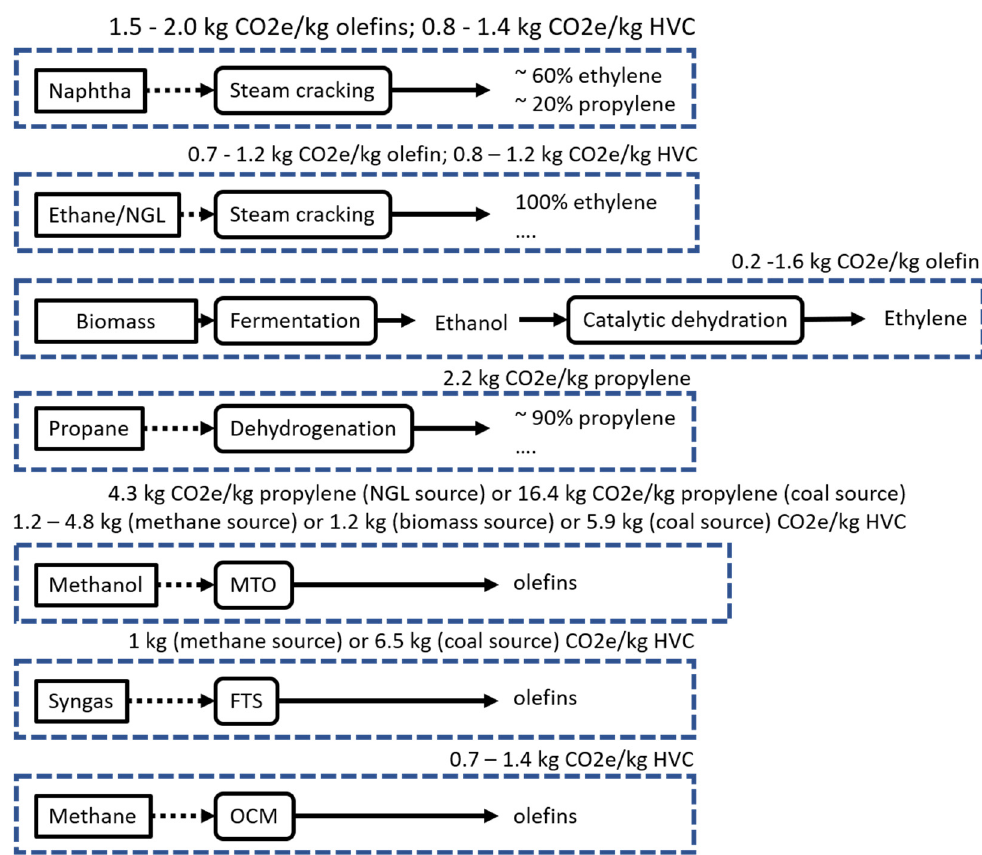
Figure 28. Schematic block diagram that describes the production of olefins through conventional and alternative processes. Data source: [2,38,42,46,47,49,53,74,98,514,531–533]. HVC: high-value chemicals.